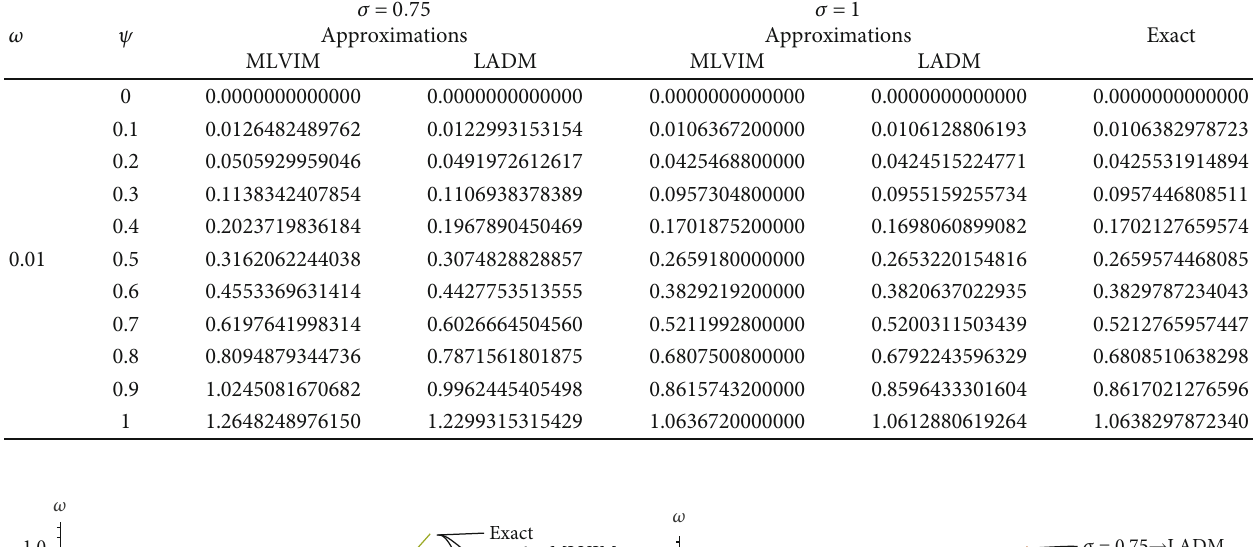
Table 3: Comparison of LADM and MLVIM solution for the fi rst three approximations with exact solution for ω = 0 : 2 , with mesh points ψ = 0 : 1 , for equation